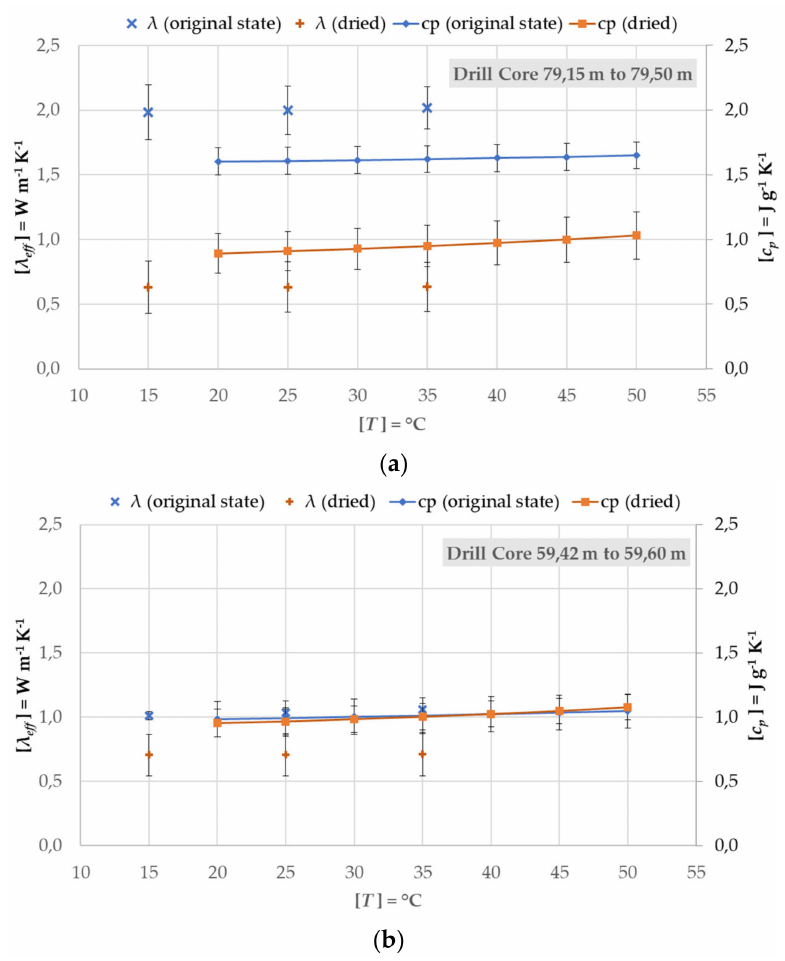
Figure 9. Summary of the results of λ ef f ( T ) and c p ( T ) at ( a ) 79.15–79.5 m and ( b ) 59.42–59.60 m depths in moist and dry